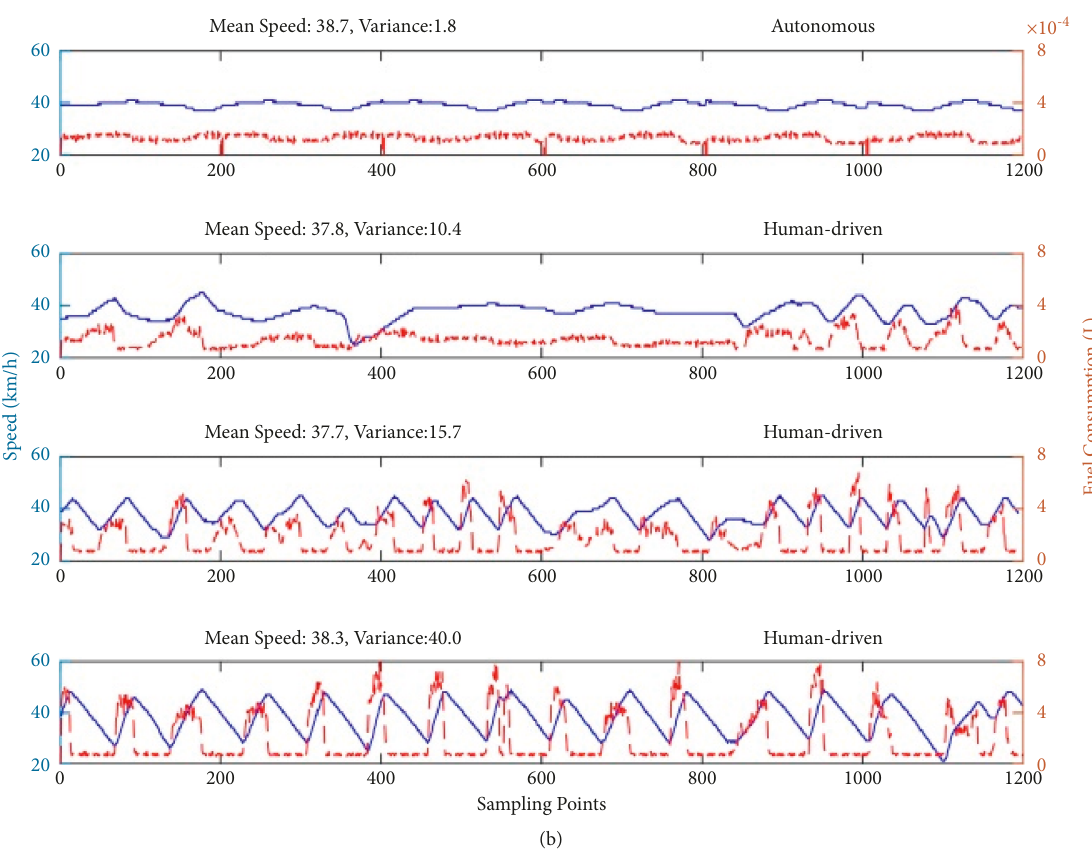
Figure 11: The different test speeds and corresponding fuel consumption. (a) Test speed at 20 km/h. (b) Test speed at